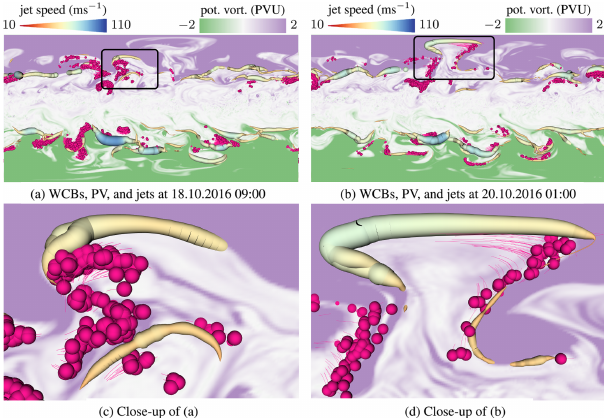
Figure 12. Visualization of jet stream and WCBs together with the potential vorticity at the upper troposphere at 270hPa. Green values indicate PV smaller than − 2 pvu and violet values indicate a PV larger than 2 pvu. White values are close to 0 pvu. On the jet stream, wind speed is mapped to color and tube radius. Panel (a) shows how a WCB pushes against the jet. Panel (b) shows the situation 2d later. The WCB injected low-PV air masses into the upper troposphere and pushed the jet stream northwards. In panels (c) and (d) , close- ups are shown.